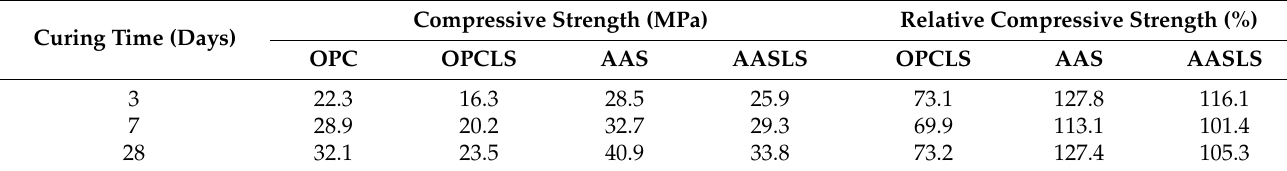
Table 5. Compressive strength using various hydration processes for different curing duration.